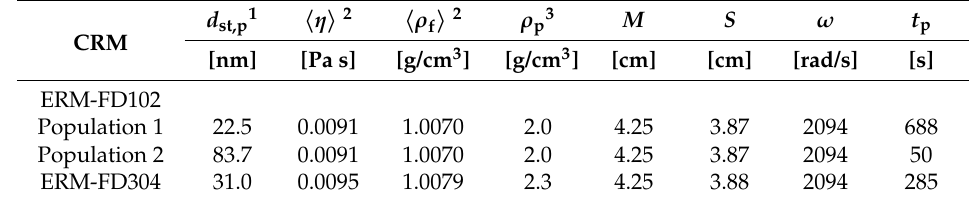
Table 1. Overview of key parameters (first replicate) for the direct calculation of Stokes diameter results using the reference disc-CLS method.